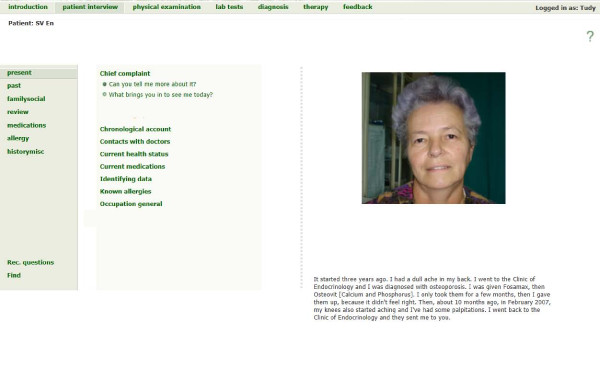
Silvia Vlasa, ENG.